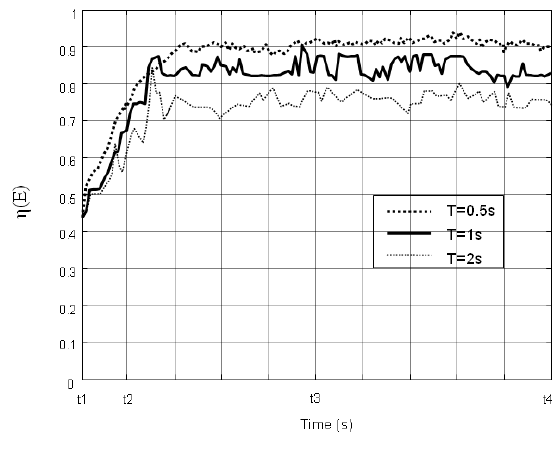
Figure 16. The varying of the coverage efficiency ( ) E η with different parameter